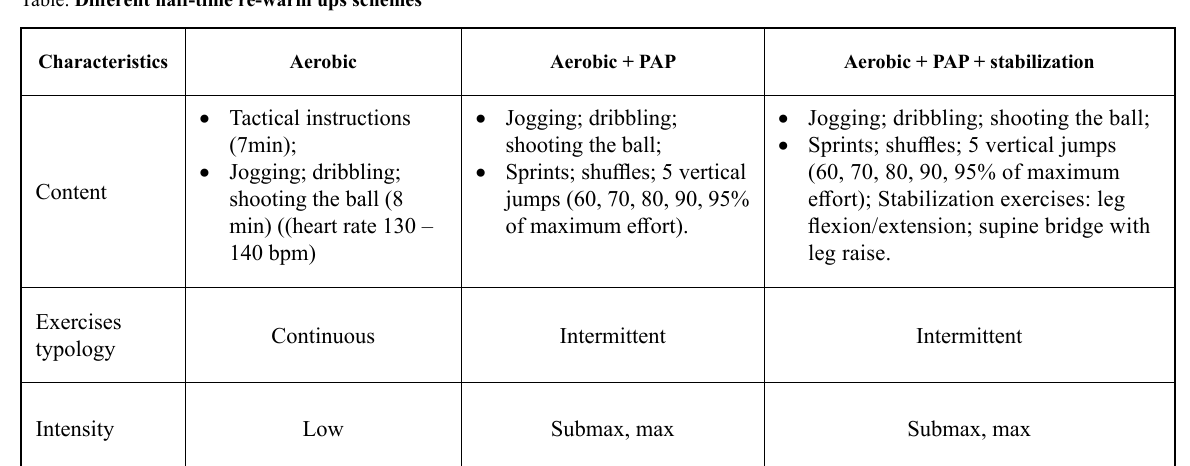
Figure 1. Mean values of counter- movement jump before and after different half-time re-warm up (average ± SD )